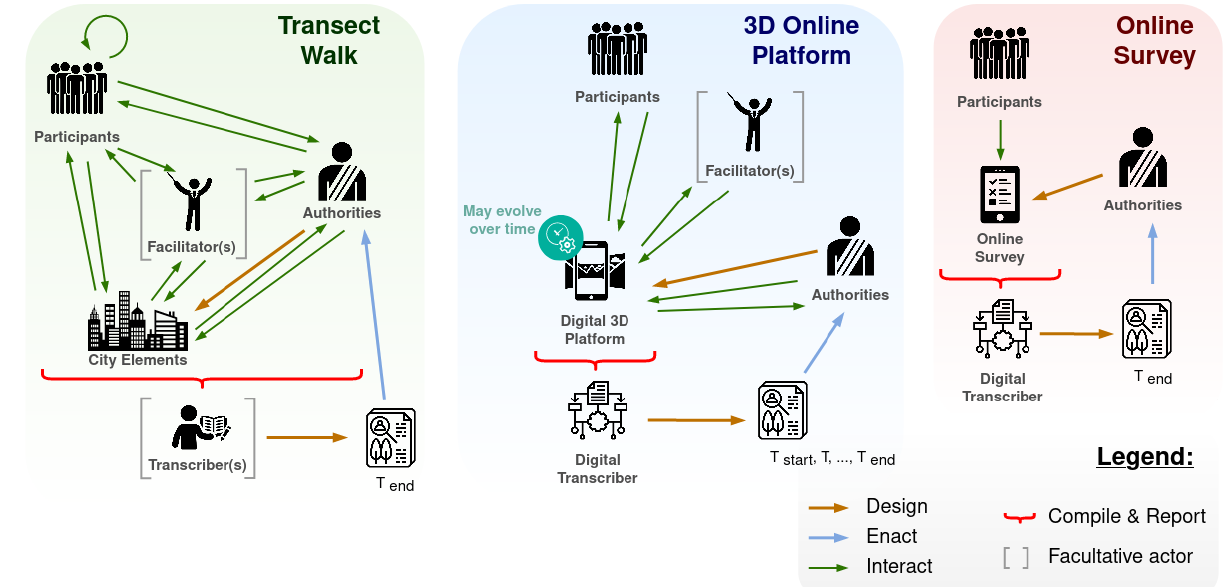
Figure 2. Schema from an actors’ interactions perspective of the three options (Transect walk, 3D online platform, and online survey) considered for this urban